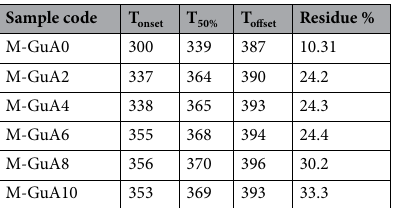
Table 2. TGA of M-GuA membranes at different % weight loss. Temperatures are stated in